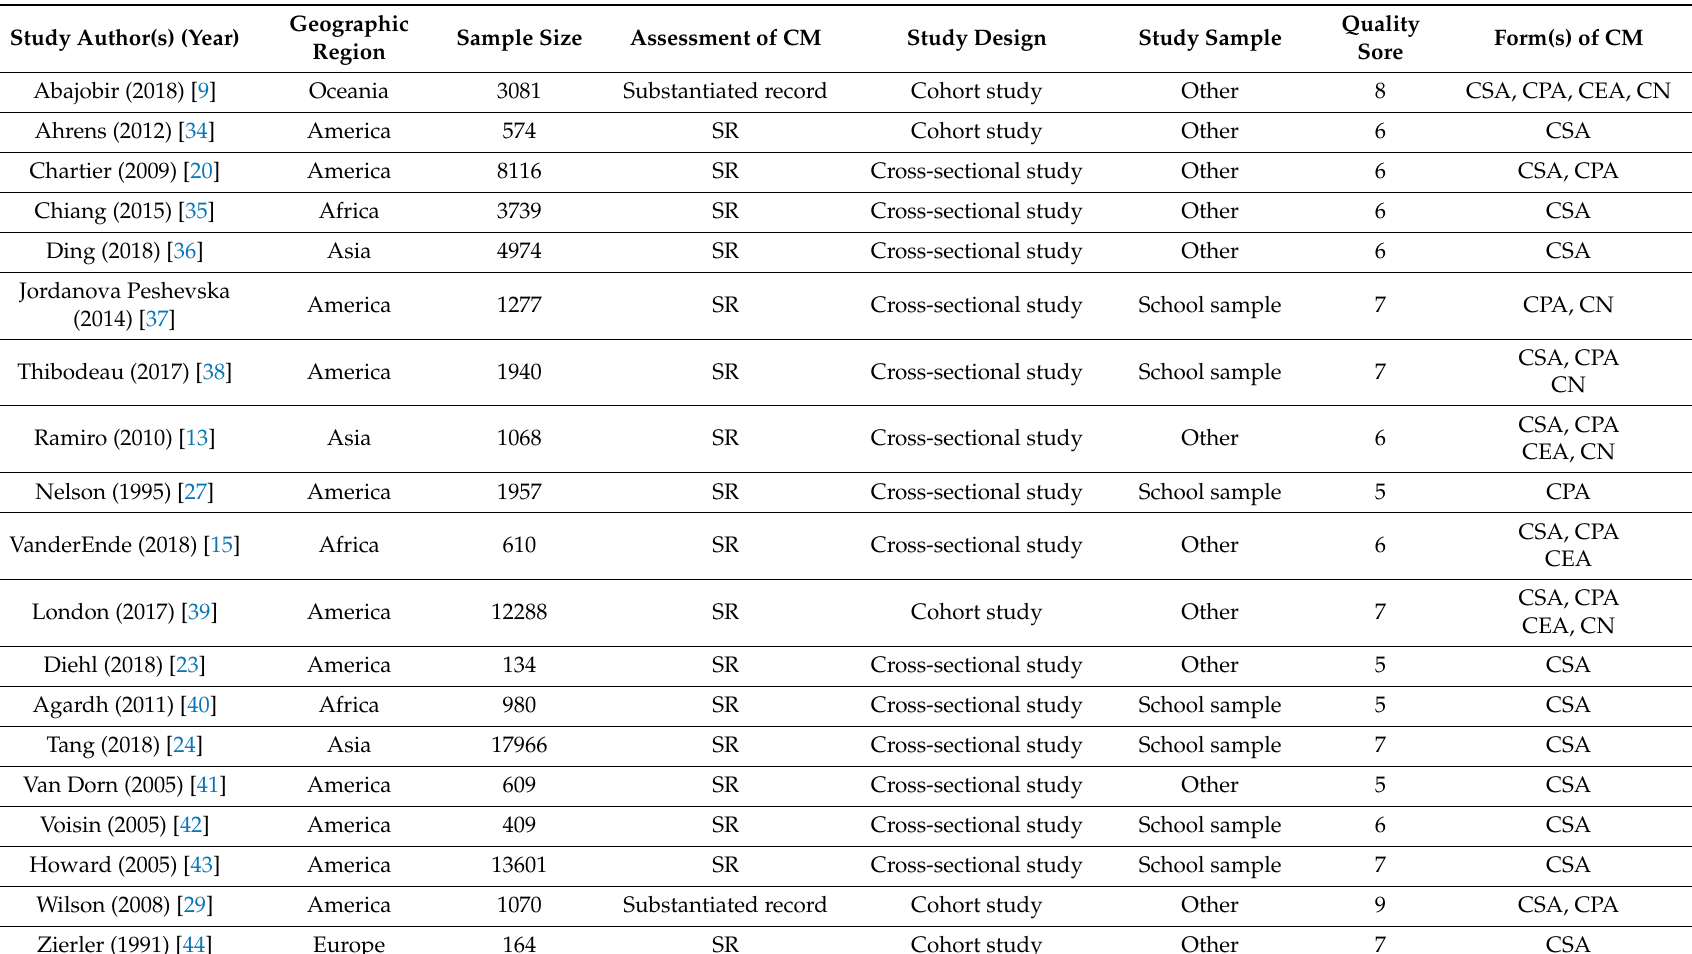
Table 1. Summary information of studies included in the